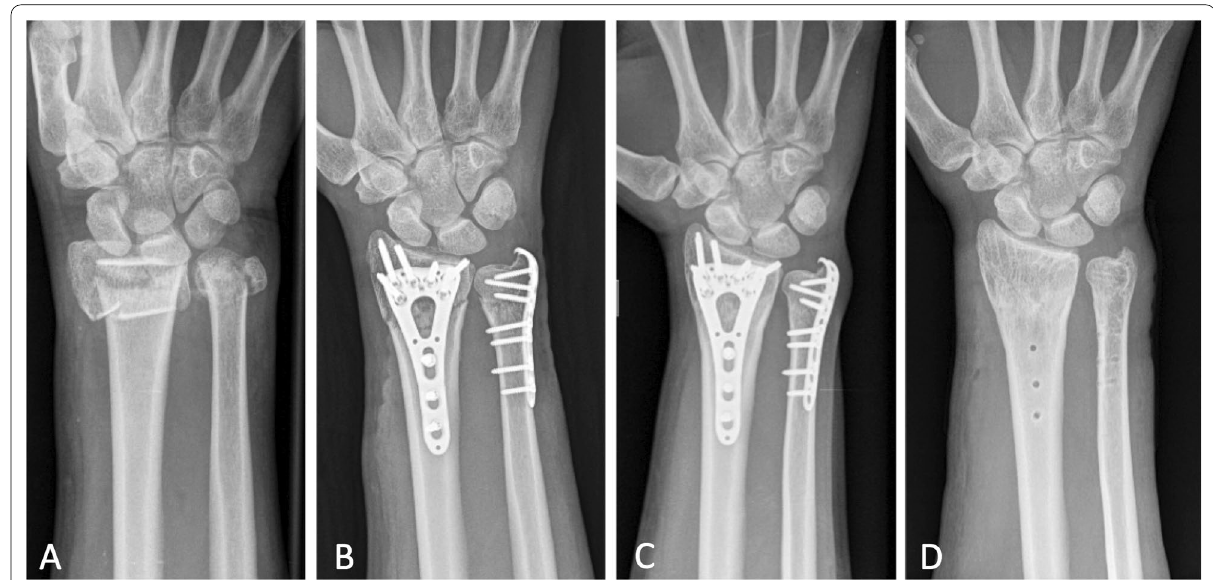
Fig. 1 Discomfort after ulna plate osteosynthesis in a young patient. A Preoperative radiograph of a 29‑year‑old female presenting a Biyani type IV right distal ulna fracture combined with a type C distal radius fracture. B Immediate postoperative radiograph showing right wrist osteosynthesis with ulna hook plate and radius volar plate. C One‑year postoperative radiograph showing ulna and radius fracture union. D Radiograph after the removal of implants due to ulna plate discomfort